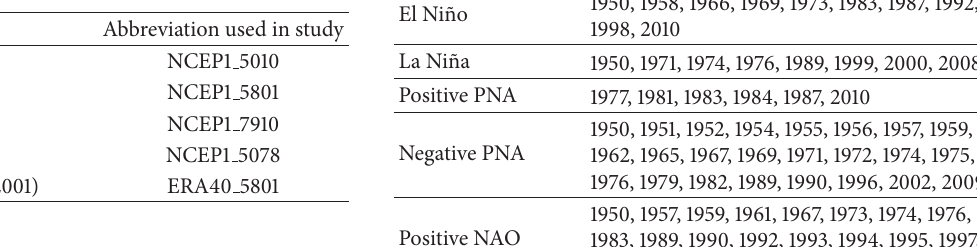
Table 1: Cyclone track climatology reanalysis datasets. Note that abbreviations include the beginning and end year of the dataset (e.g., NCEP1 5010 represents Reanalysis I data from 1950 to 2010).